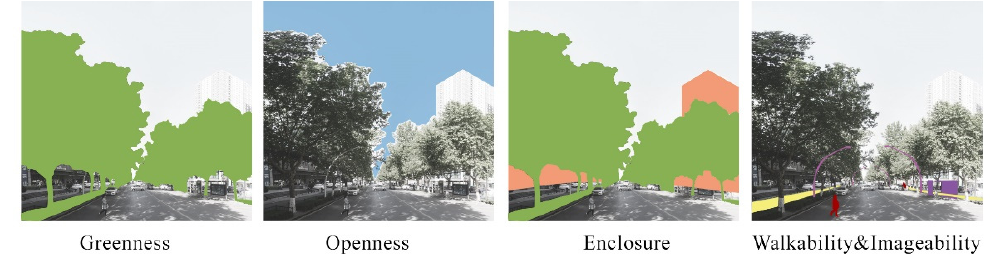
Figure 6. Sketches of the five aspects represent streetscape perception.